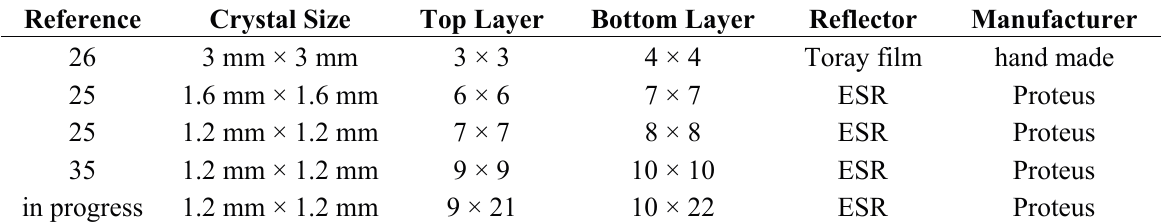
Table 3. Evolution of dimensions and crystal configurations used.